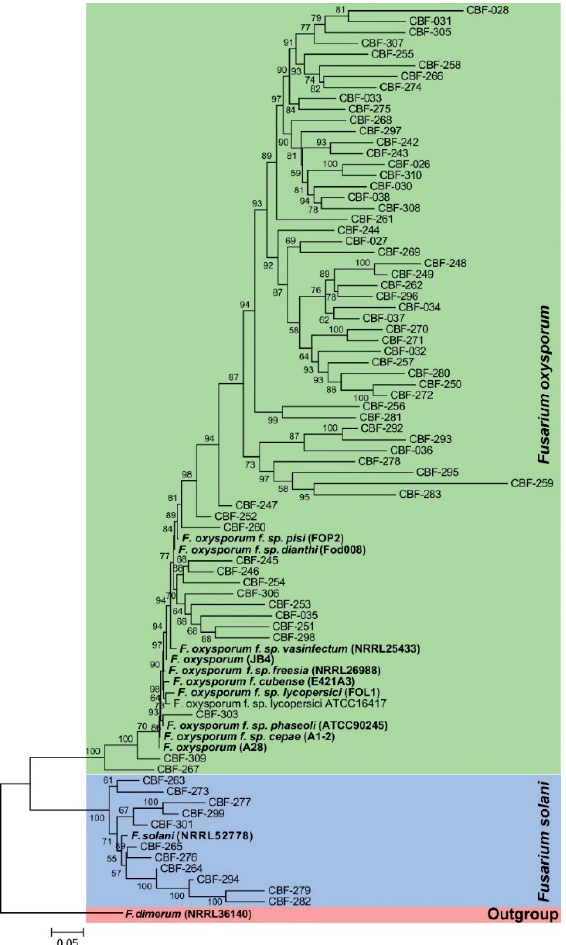
Figure 1. Phylogenetic tree of Fusarium isolates associated to coffee corky-root disease. The maximum likelihood tree was inferred from the concatenated EF-1 α , RPB2 , and TUB2 genes sequence data set of the 70 isolates, based on the best model Hasegawa–Kishino–Yano (HKY + G), bootstrap values ( n = 1000). The bar indicates 0.05 substitution per site. The tree is rooted through the outgroup Fusarium dimerum (NRRL36140). Reference sequences from Fusarium -ID database and GenBank included in the analysis are highlighted in bold letters.